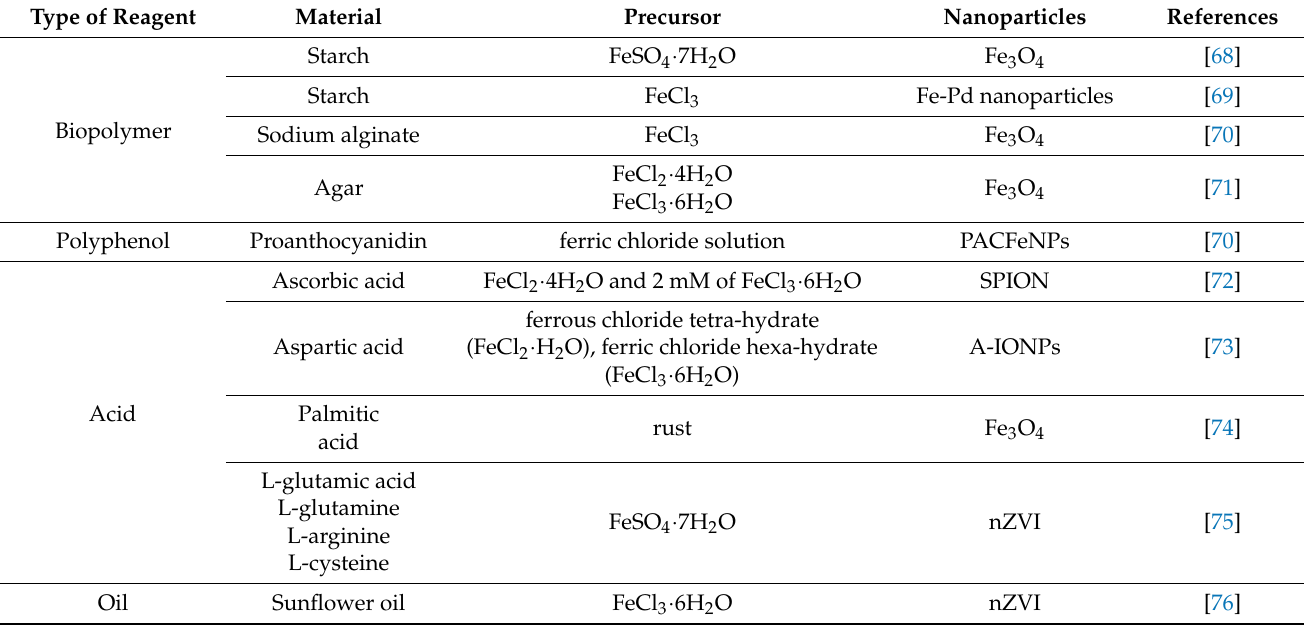
Table 4. Examples of synthesis of iron nanoparticles using green